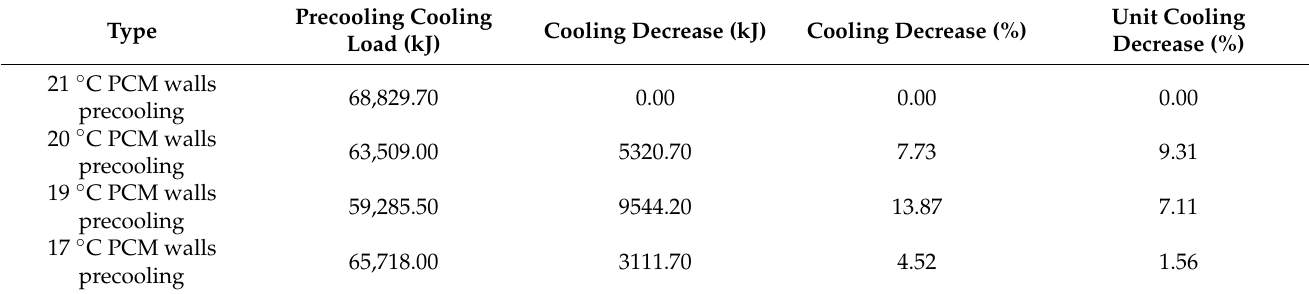
Table 5. Changes in precooling cooling load at various precooling